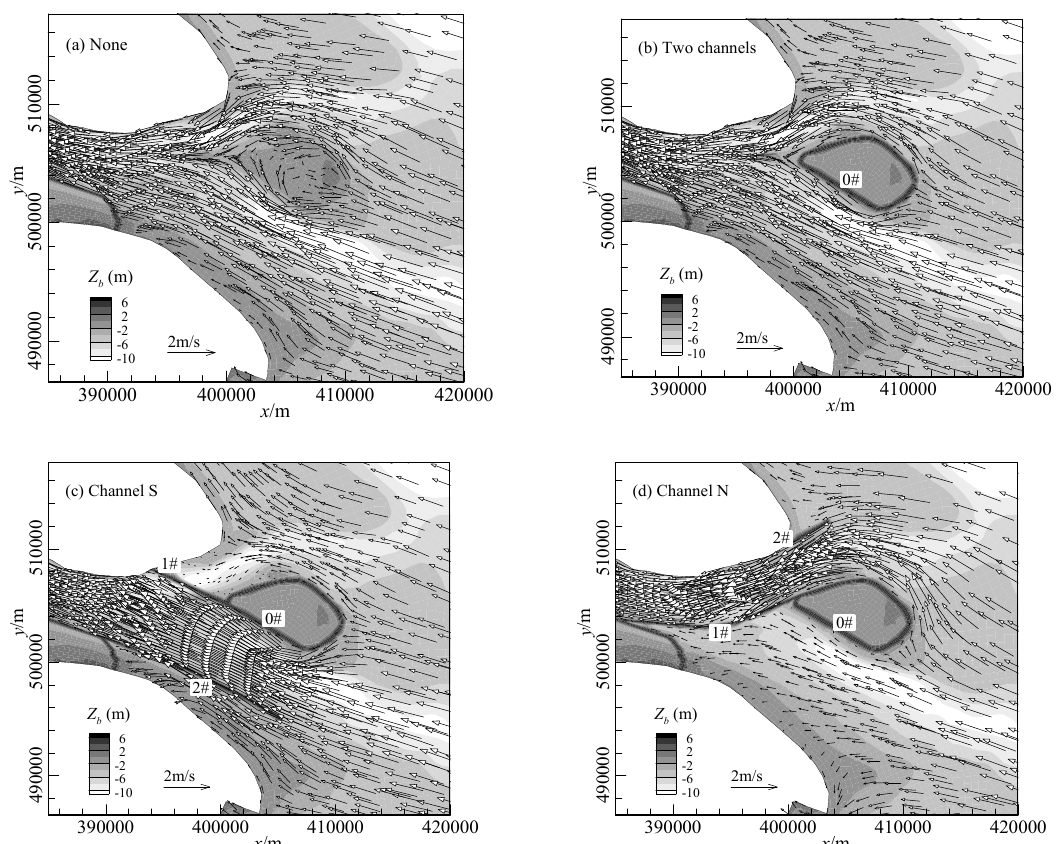
Figure 8. Velocity fields under different designs at flood-tide ( t = 12 h).